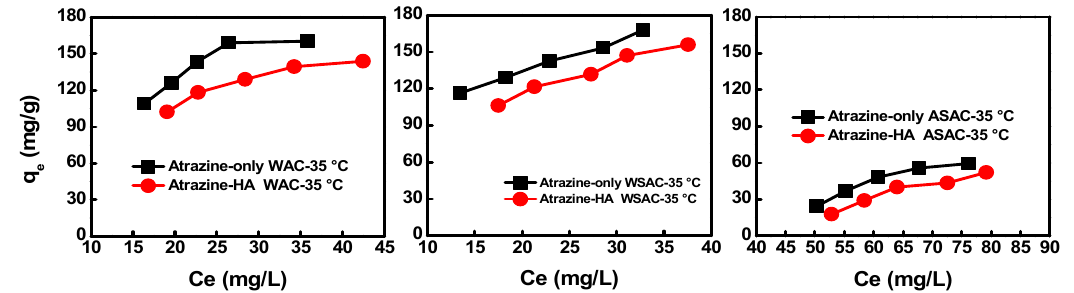
Figure 5. Effect of HA on the adsorption of atrazine onto WAC ( a ), WSAC ( b ), ASAC ( c ) (C HA = 20 mg/L). Table 8. Effect of HA on adsorption isotherm parameters of atrazine onto ACs.